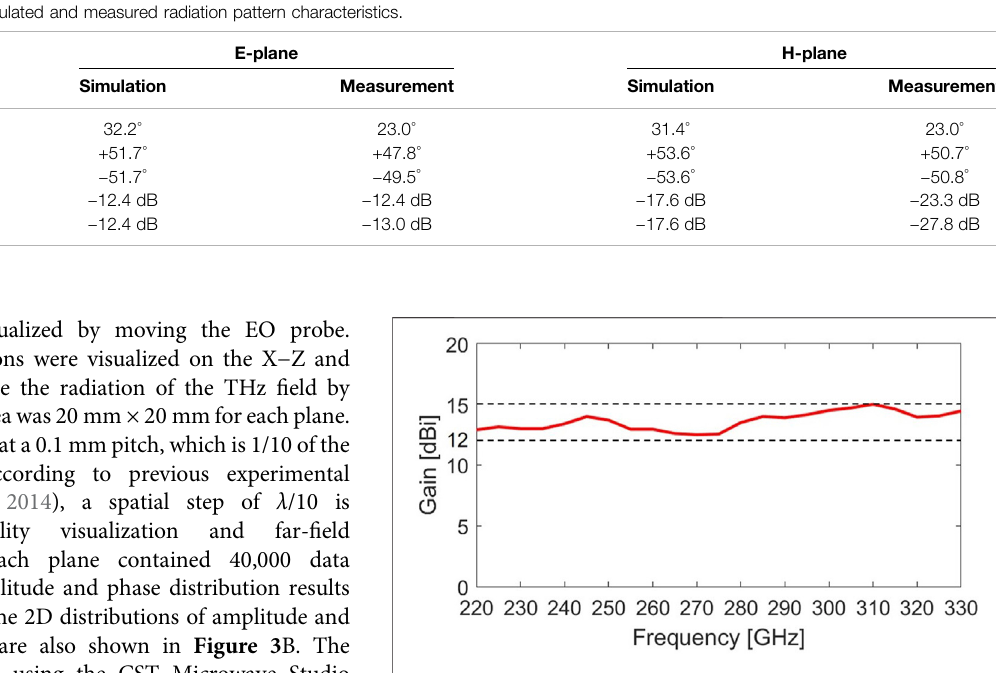
FIGURE 5 | Calculated frequency characteristic of the antenna gain of DCA. The calculation was performed using CST Microwave Studio software, and the gain results were